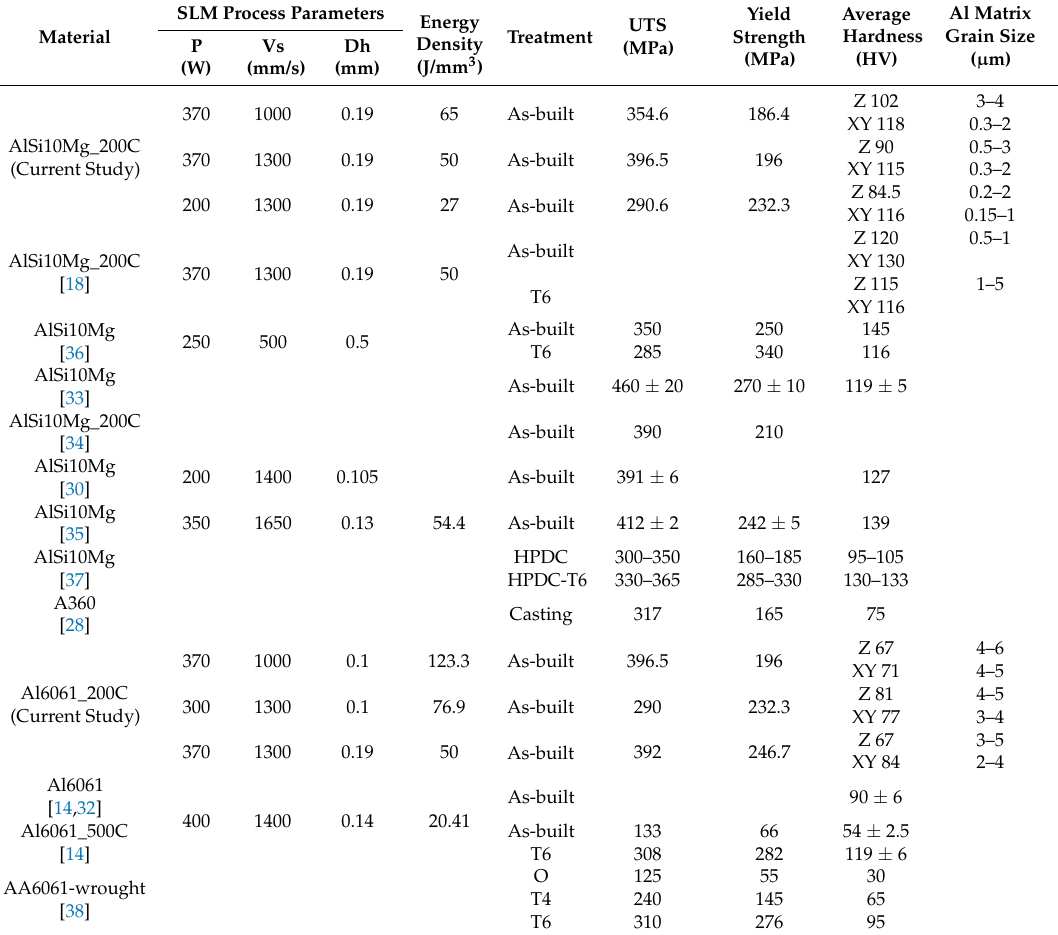
Table 6. A summary of mechanical properties microstructure grain size of the AlSi10Mg and Al6061 parts processed though SLM and the conventional techniques under different